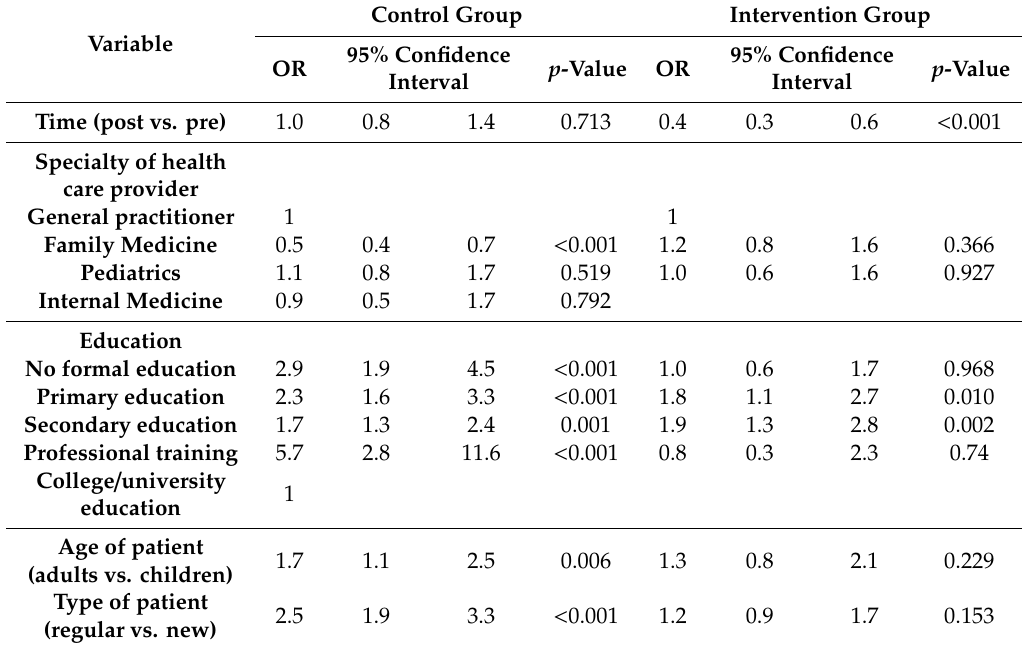
Table 3. Multivariate analysis of factors associated with antibiotics demand in the control and intervention